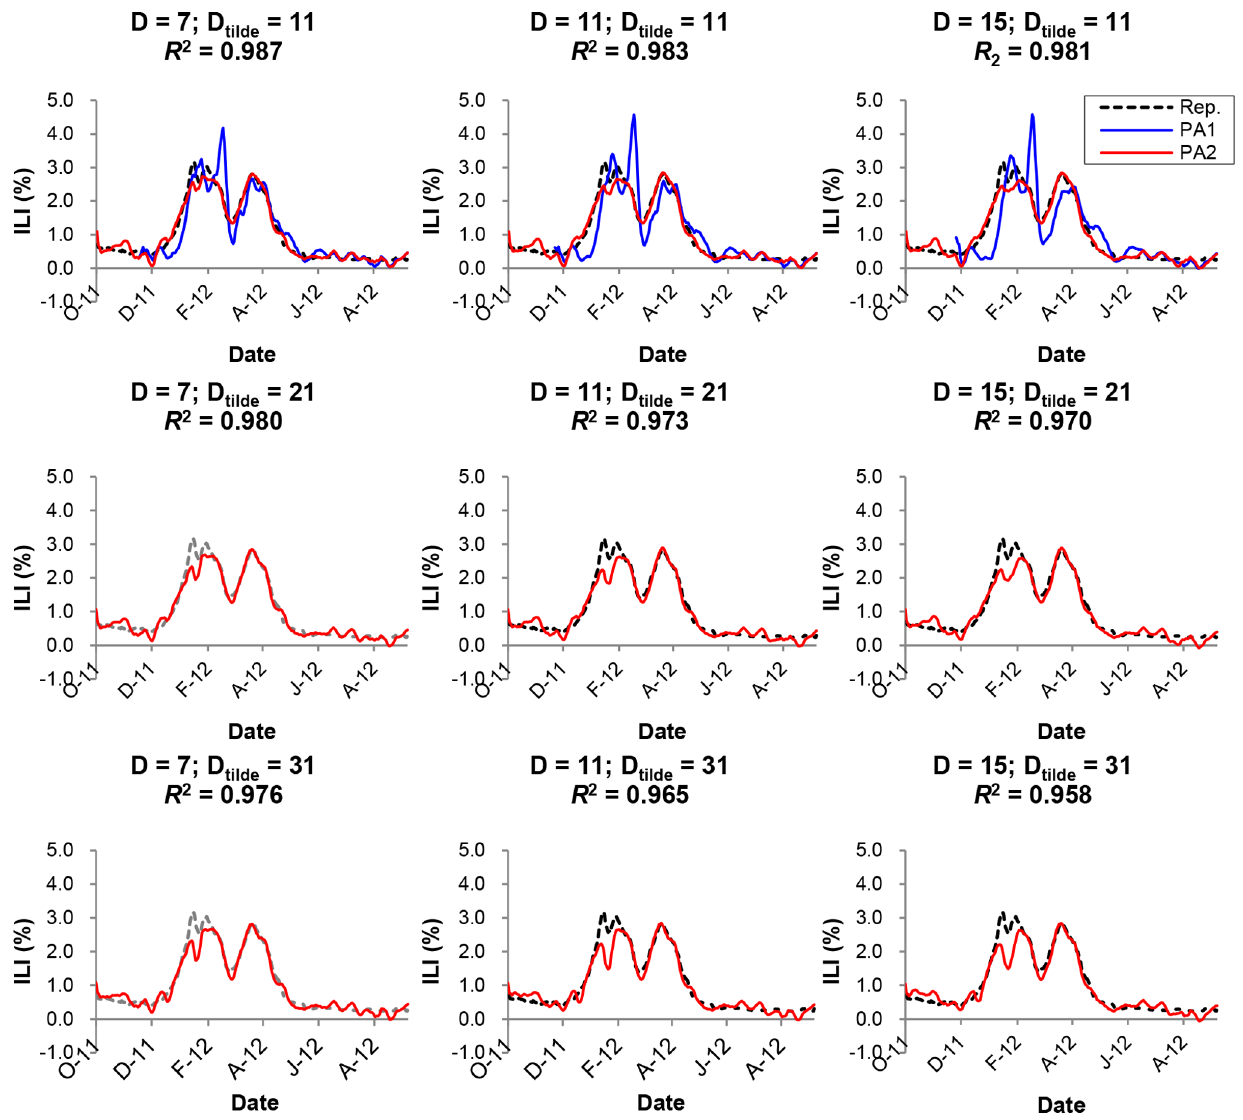
Figure 6. PA2: Comparison of y and ^ yy . The predicted values of ILI are compared with those reported by the KCDC for D ~ 7,11,15 and ~ DD ~ 11,21,31 . The curves obtained using PA1 (blue lines) were superimposed for comparison. A) ~ DD ~ 11 and D ~ 7,11,15 . B) ~ DD ~ 21 and D ~ 7,11,15 . C) ~ DD ~ 31 and D ~ 7,11,15 .